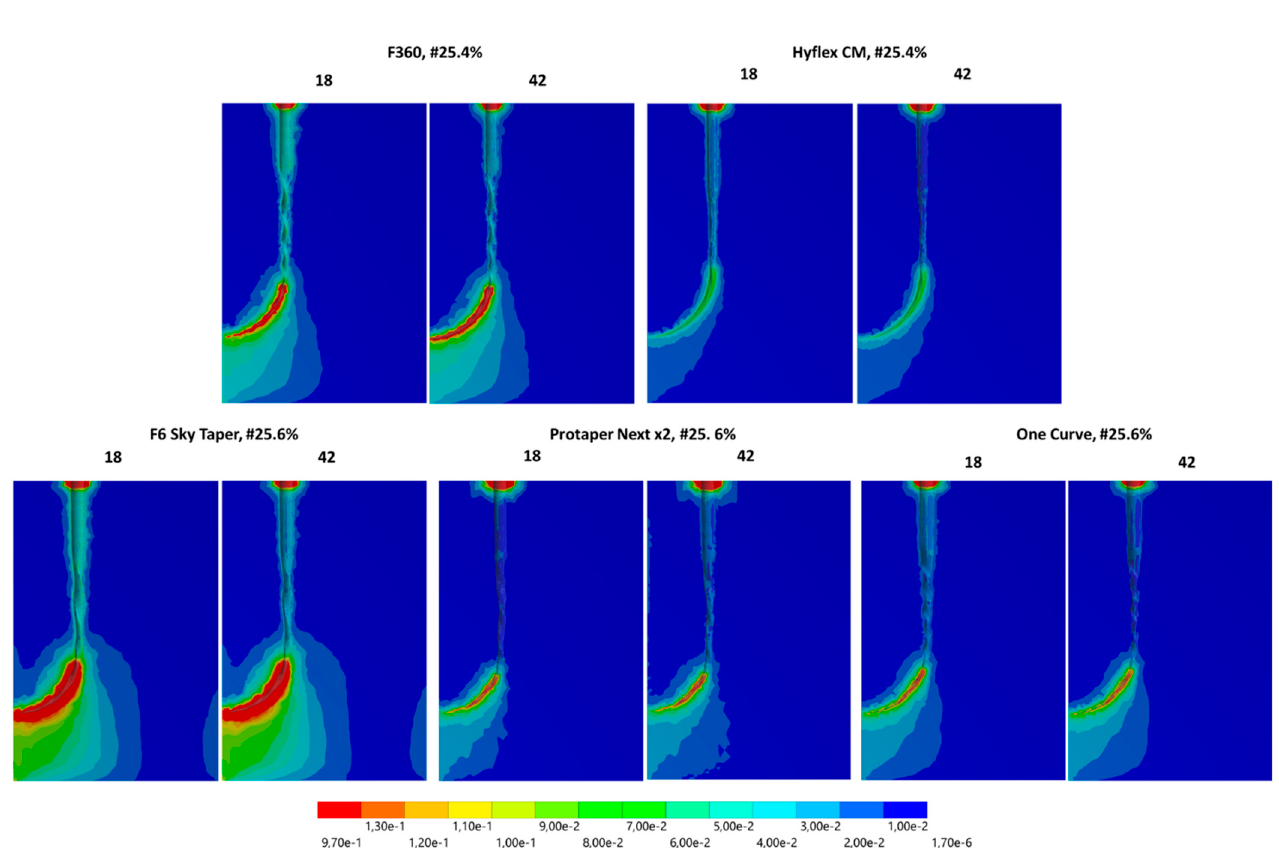
Figure 8. Von Mises stress distribution and propagation in the dentine with the two different values of dentine elastic modulus (18 or 42 GPa).